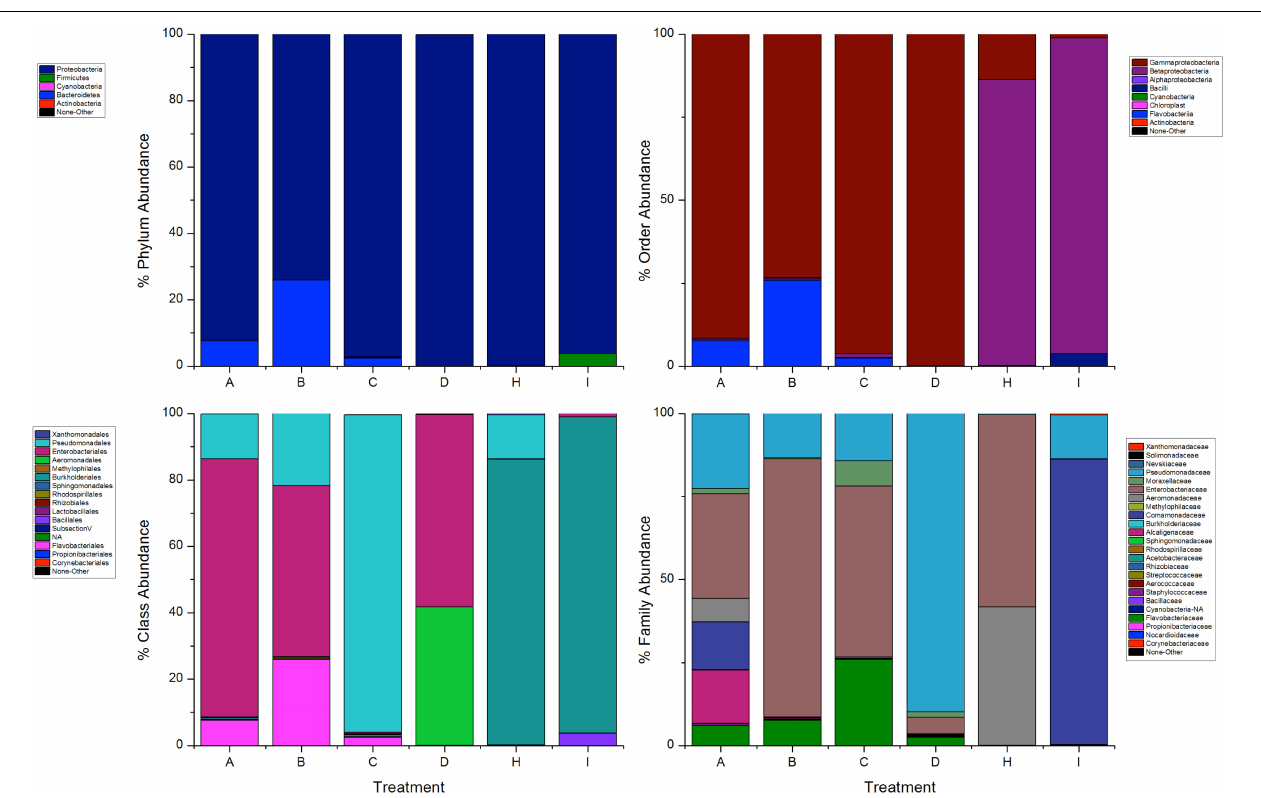
FIGURE 3 | Taxonomic variation between groups of A. aegypti exposed to permethrin. A: fed with sucrose 10%, B: exposed to permethrin (control group), C: treated with penicillin/streptomycin permethrin exposed, D: treated with gentamicin permethrin exposed, H: treated with penicillin/streptomycin (not exposed), I: treated with gentamicin (not